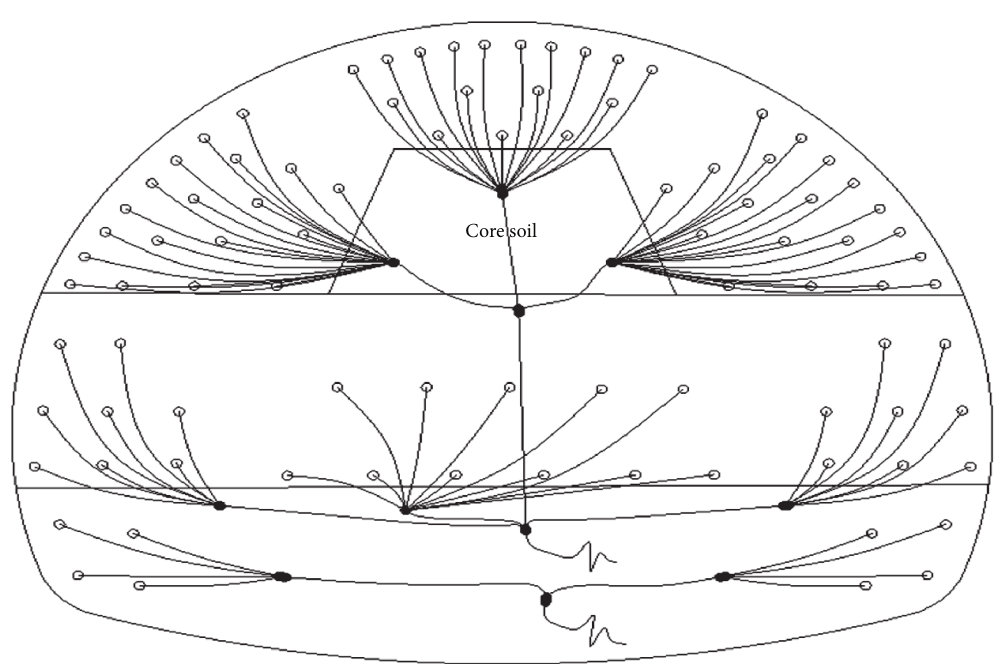
Figure 4: Nonelectric detonator initiation network diagram of Muzhailing Tunnel.